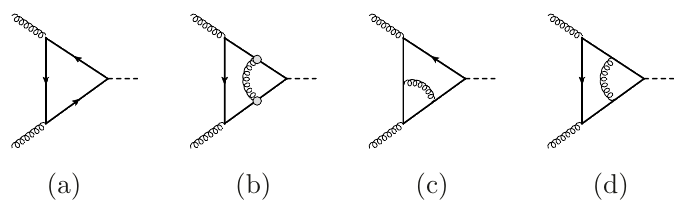
Figure 4 . The Feynman diagram for (a) the leading order one-loop Higgs boson production in gluon fusion, (b) the effective soft gauge boson exchange similar to figure 1(b), (c) gluon and (d) Higgs boson vertex